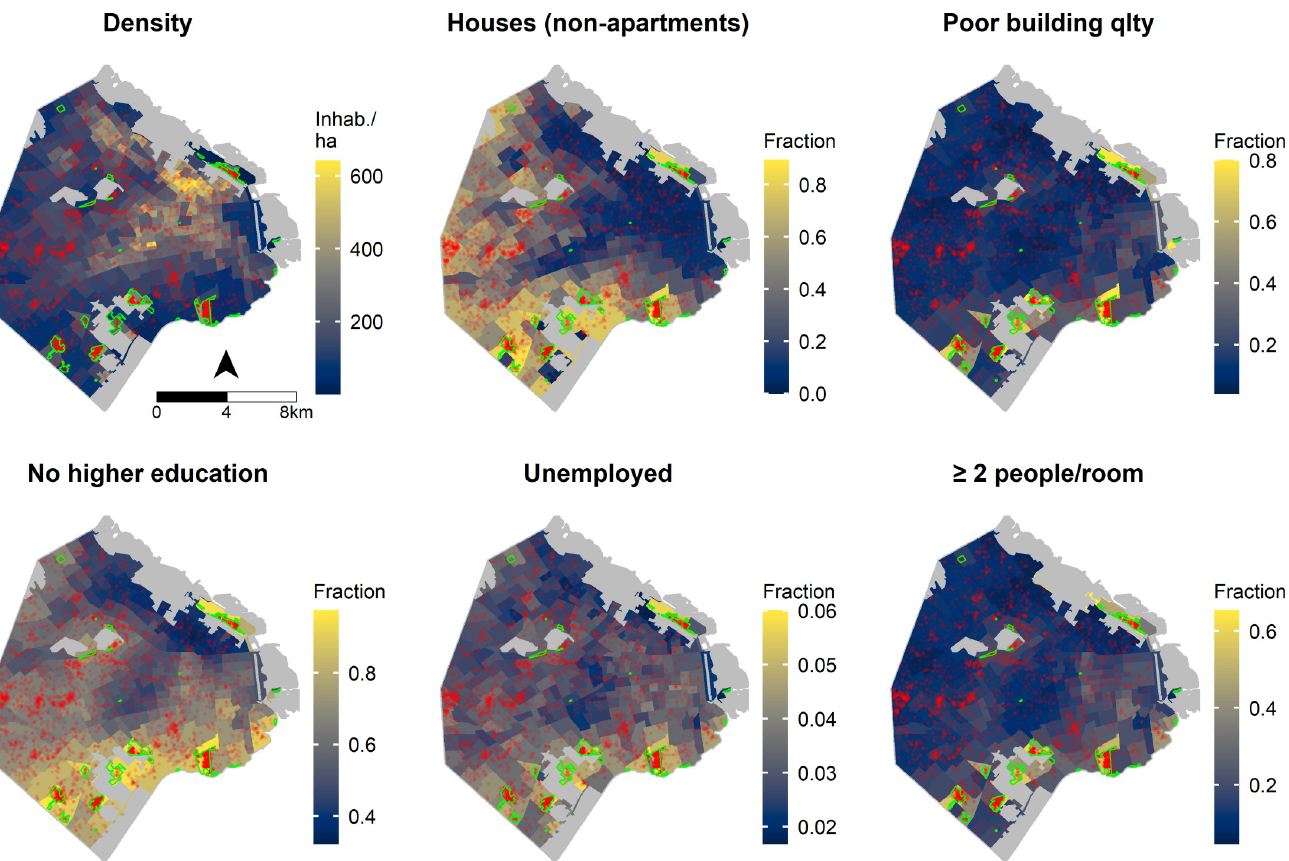
Fig 1. Distribution of inhabitant density, demographic covariates, and dengue autochthonous cases in Buenos Aires. Covariates are quantified as the fraction (or proportion) of dwellings or people–depending on the covariate–in each census fraction that correspond to the considered category. These five covariates were included in the hierarchical model. All autochthonous cases occurring during the outbreak are displayed as red points. Grey shaded areas are uninhabited. Green polygons show the limits of slums. The spatial unit displayed is the census fraction. Map base layer downloaded from the open-data repository of the Government of the City of Buenos Aires